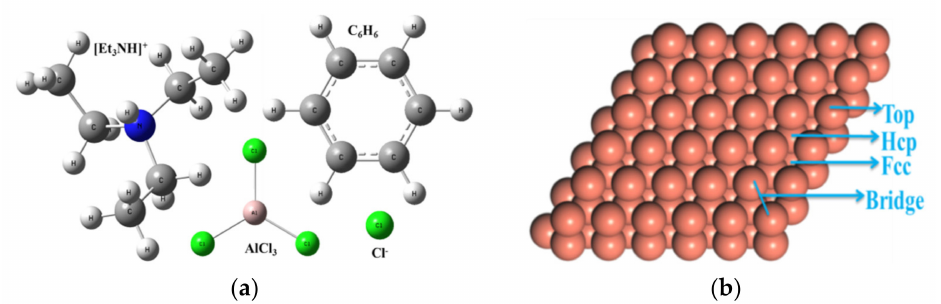
Figure 1. The stable geometry of molecules or ions in molecular dynamics simulation ( a ) and the schematic diagram of different adsorption sites on Cu(111) surface ( b